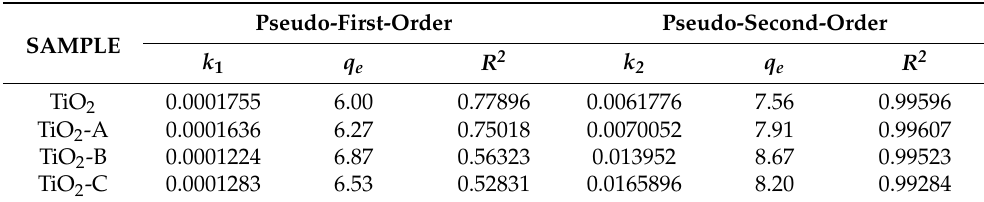
Table 3. Kinetic parameters of pseudo-first-order and pseudo-second-order models calculated from experimental data of pure and Fe-doped TiO 2